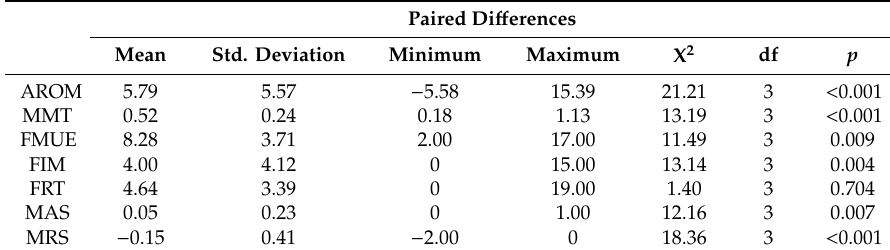
Table 3. Independent Kruskal–Wallis.